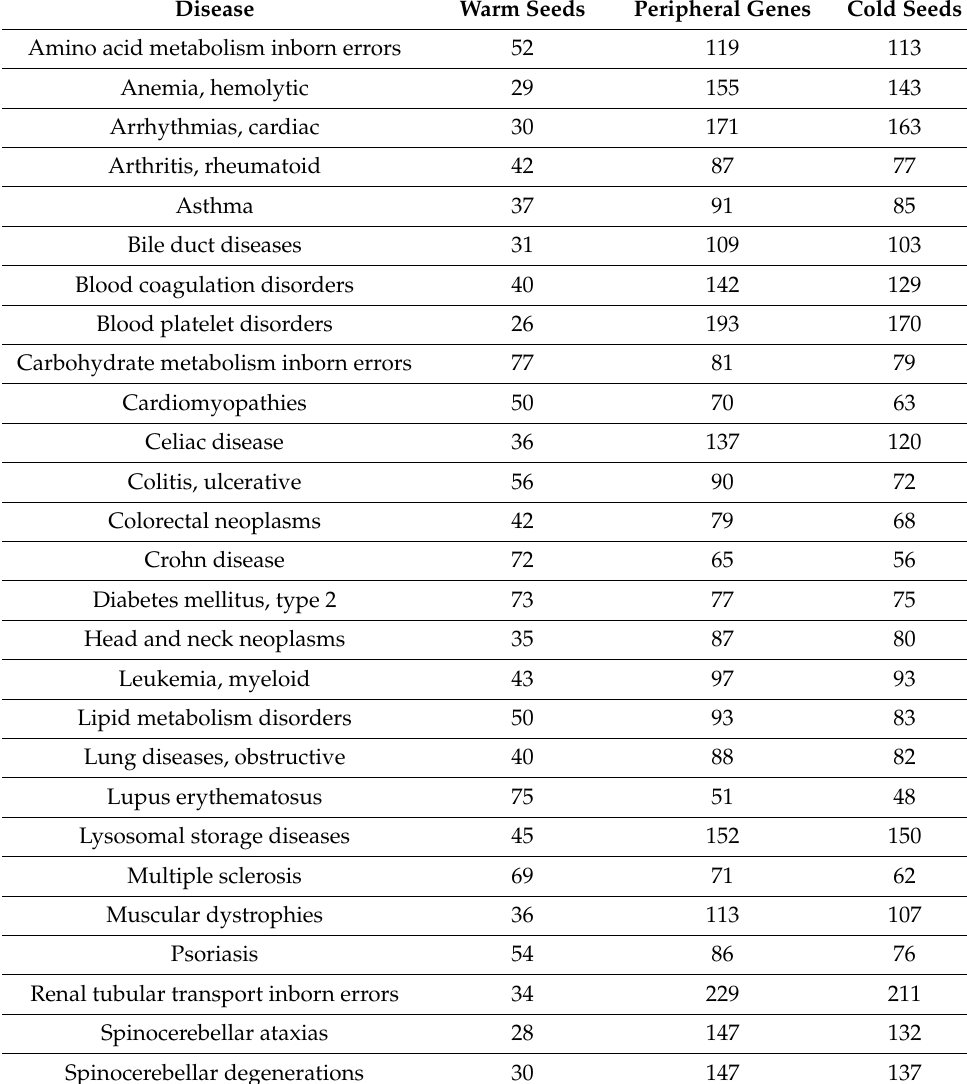
Table 1. Cardinalities of the 3 genes sets: WSs, peripheral genes (application of network-based distance constraint) and CSs (application of both network-based and functional distance constraints). Disease Warm Seeds Peripheral Genes Cold Seeds Amino acid metabolism inborn errors 52 119 113 Anemia, hemolytic 29 155 143 Arrhythmias, cardiac 171 163 Arthritis, rheumatoid